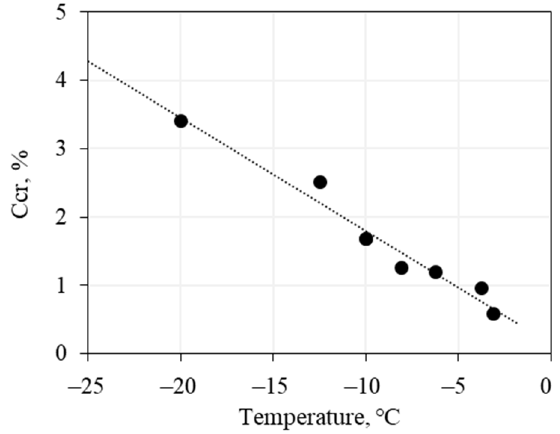
Figure 5. Temperature dependence of critical salt concentration ( C cr ) required for complete dissocia- tion of pore gas hydrate in frozen sand at 0.1 MPa ( C sol = 0.1N).